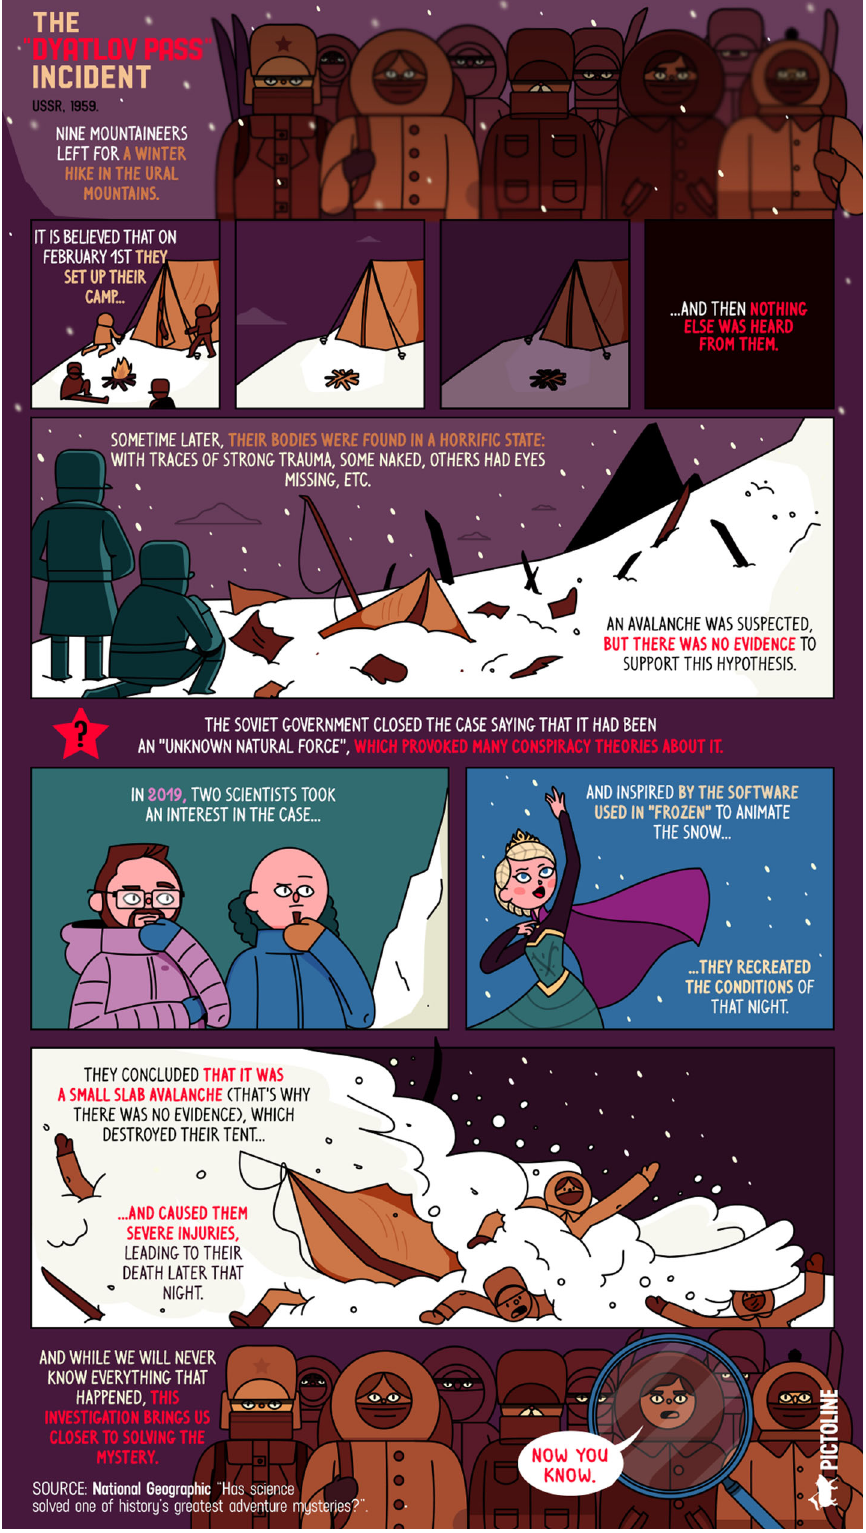
Fig. 1 Infographics inspired by the Dyatlov Pass Incident and our paper in Communications Earth & Environment . The authors are depicted as comic heroes. Courtesy of PICTOLINE: